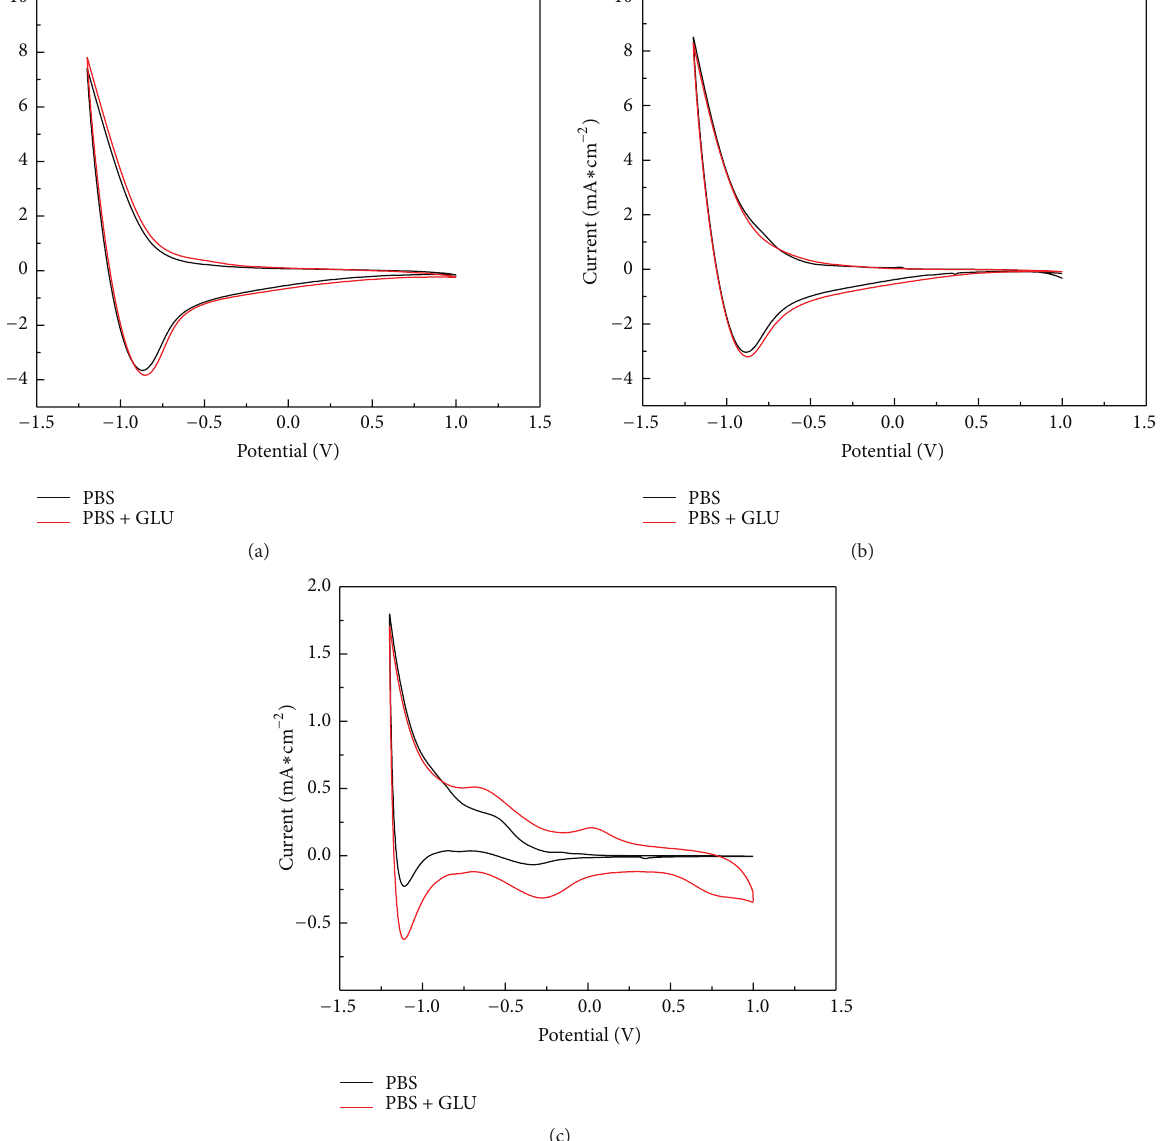
Figure 3: CVs of TiO 2 (a), Ag-TiO 2 (b), and Ag-TiO 2 (500 ∘ C) (c) electrode in 0.1M neutral PBS with (red line) or without (black line) 0.2 M